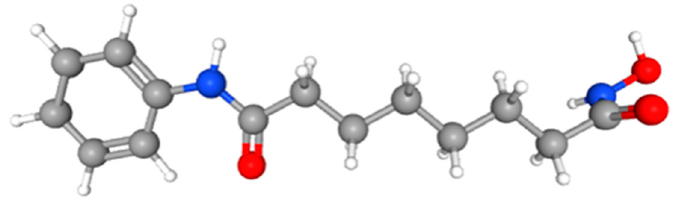
Figure 3. Chemical Structure of Vorinostat [92].